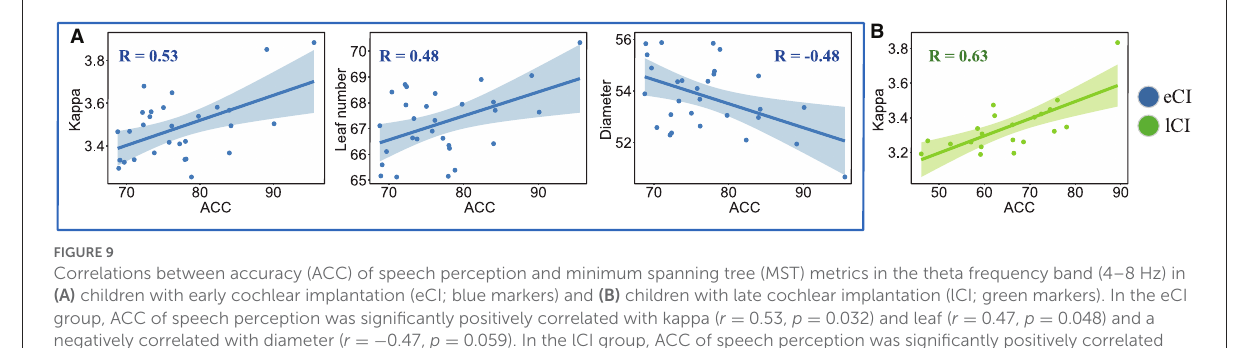
FIGURE9 Correlations between accuracy (ACC) of speech perception and minimum spanning tree (MST) metrics in the theta frequency band (4–8 Hz) in (A) children with early cochlear implantation (eCI; blue markers) and (B) children with late cochlear implantation (lCI; green markers). In the